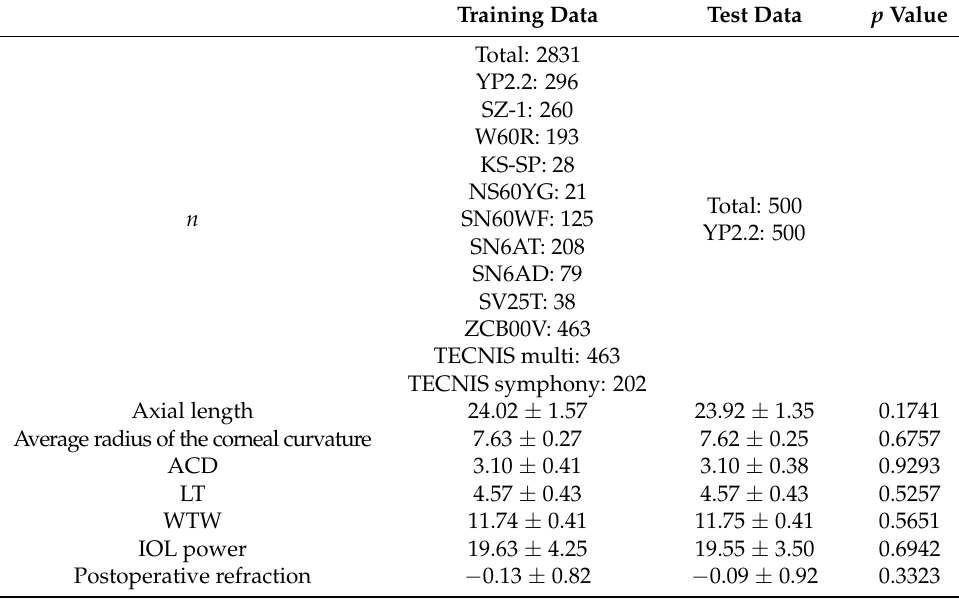
Table 1 contains a summary of the training and test data. No significant difference was observed between the two groups in age, axial length, radius of corneal curvature, lens thickness, anterior chamber depth, white-to-white distance, refractive power of the implanted IOL, and postoperative refraction. Abbreviations: ACD, anterior chamber depth; LT, lens thickness; WTW, white-to-white distance p -values were calculated using an unpaired t -test. The correction of multiple comparisons was not